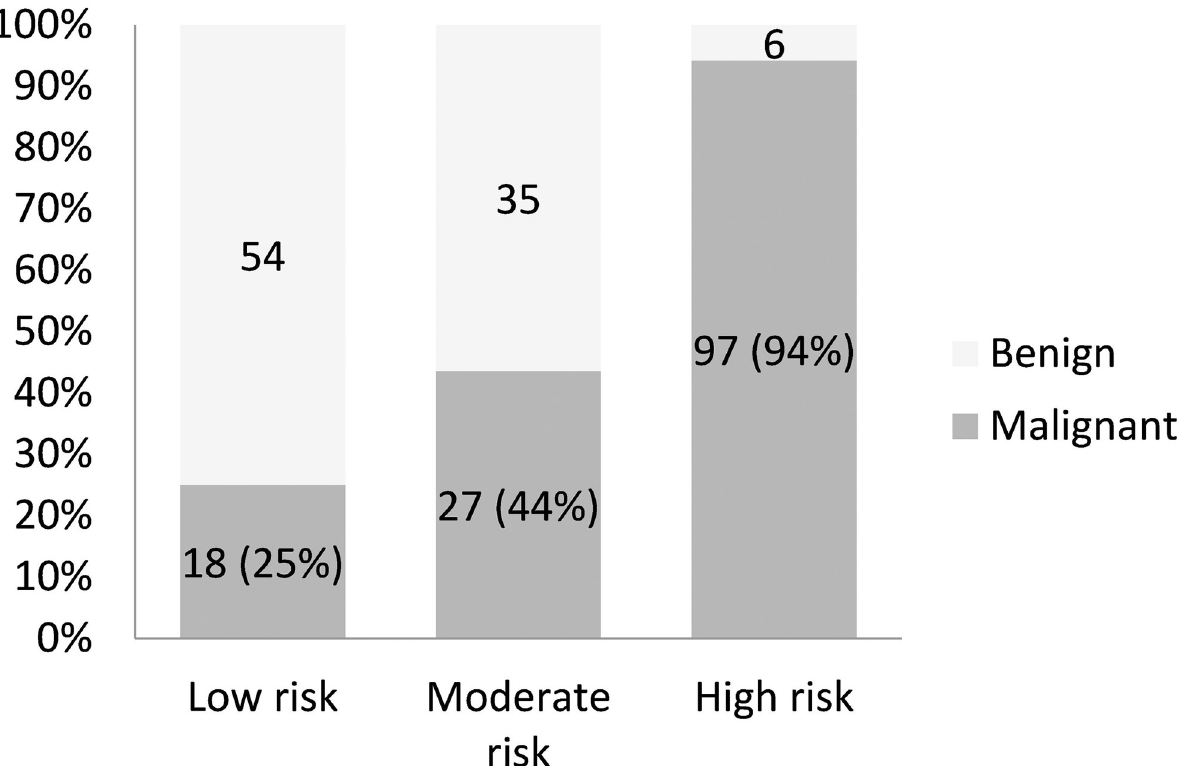
Fig 1. Final malignancy rates of indeterminate cytology among different cytological classifications.